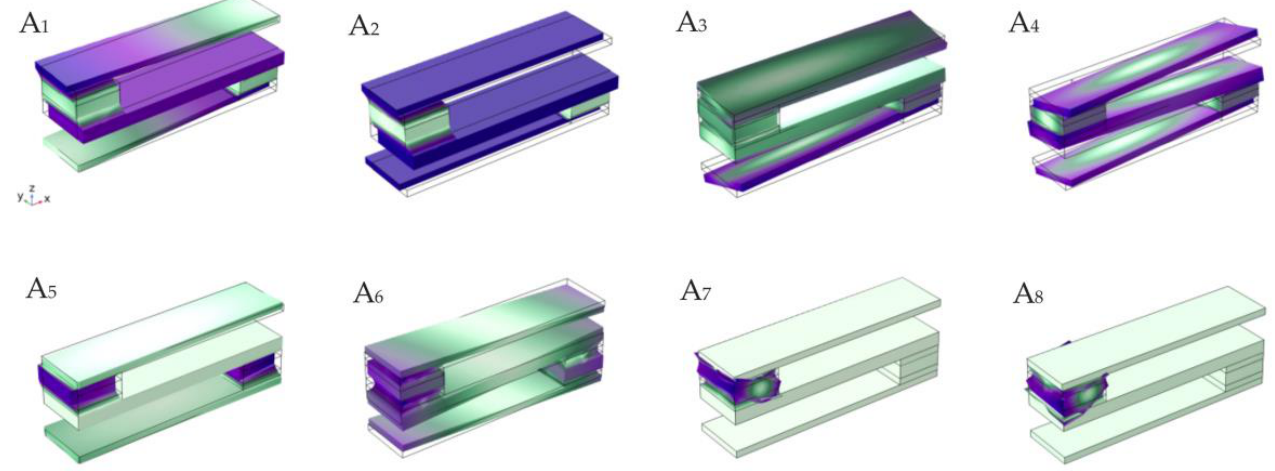
Figure 4. The displacement fields of eigenmodes labeled in Figure 2a.